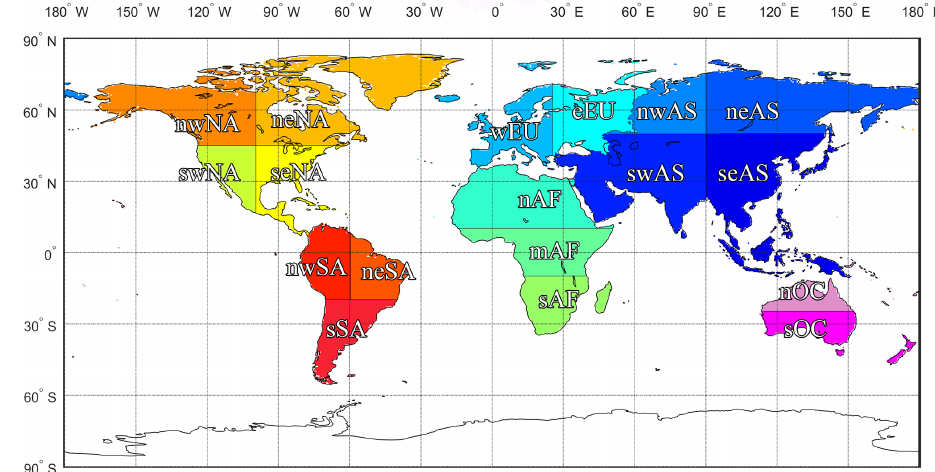
Figure 3. The definitions of the continental regions in this study. The uppercase letters in the region names represent the names of their continents: North America (NA), South America (SA), Europe (EU), Africa (AF), Asia (AS), and Oceania (OC). The lowercase letters in the region names represent the subregions inside the continent: northern (n), southern (s), western (w), eastern (e), middle (m), northwestern (nw), northeastern (ne), southwestern (sw), and southeastern (se).